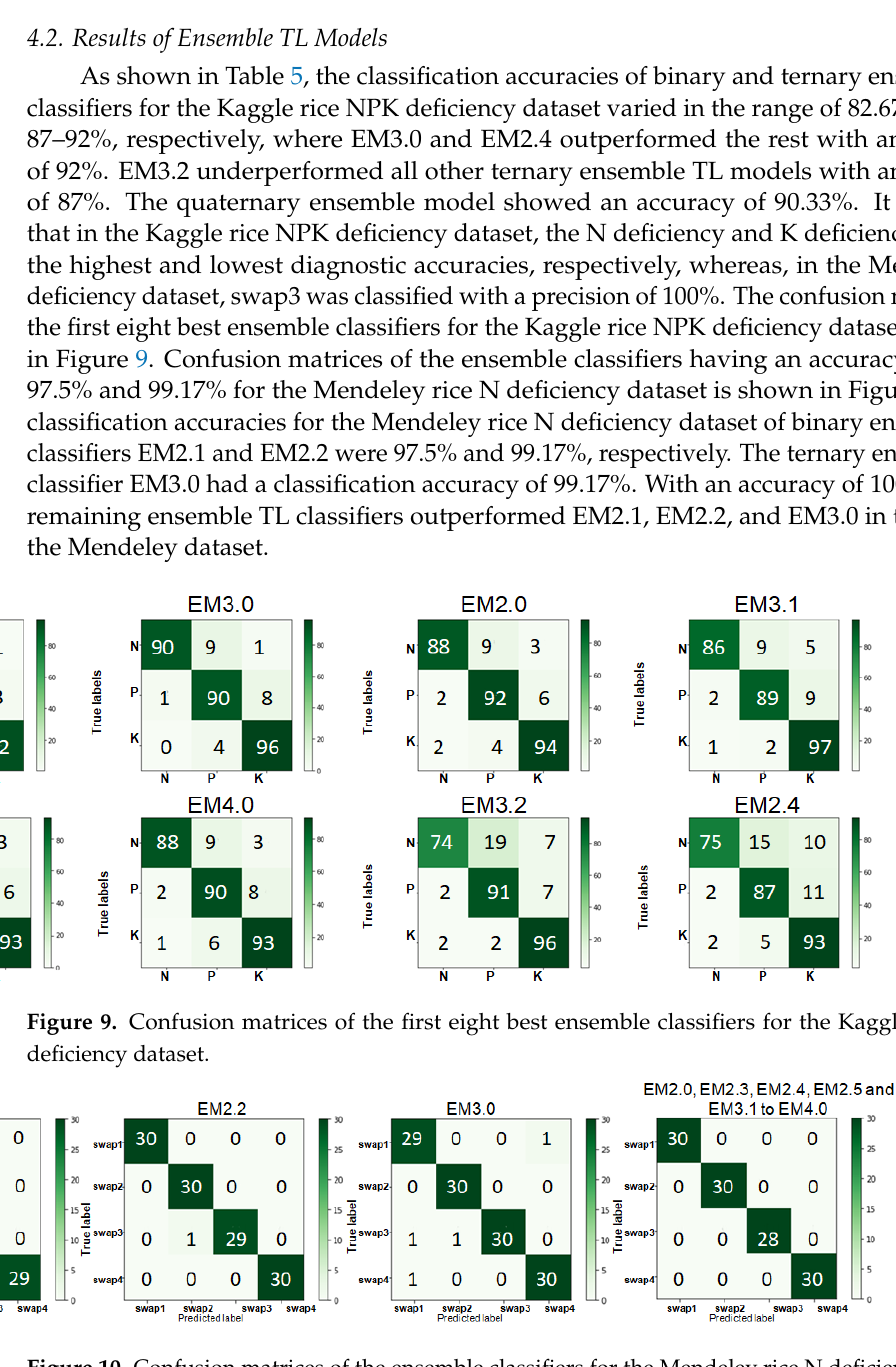
Figure 10. Confusion matrices of the ensemble classifiers for the Mendeley rice N deficiency da- taset.